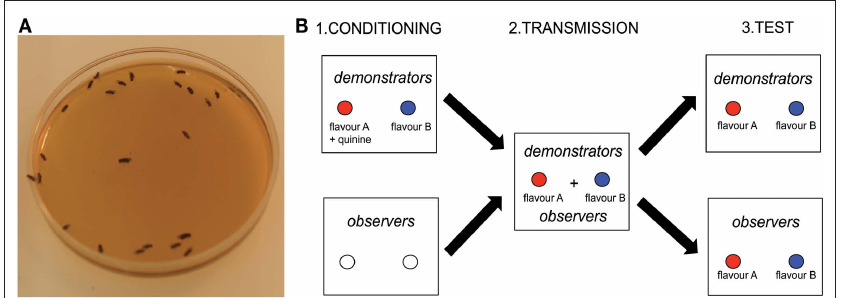
Figure 1 | Social learning of oviposition preferences in Drosophila melanogaster . (A) Drosophila females aggregated on a standard oviposition medium (credit ML). (B) Battesti et al. (2012) tested the role of social information use in the oviposition decisions of Drosophila females exposed to two equally rewarding oviposition media characterized by a distinct artificial flavor (A or B). The same general paradigm was used in all experiments. During the conditioning phase, “demonstrator” flies were conditioned to associate flavor A with quinine (non-preferred medium) and flavor B with the absence of quinine (preferred medium). “Observers” were trained with odor-free media and thus remained naïve to the flavors. During the transmission phase, demonstrators and observers were exposed together to the two flavored media without quinine. During the test phase, demonstrators and observers were exposed separately to the two flavored media. Social transmission was successful if the oviposition preference of observers mirrored that of